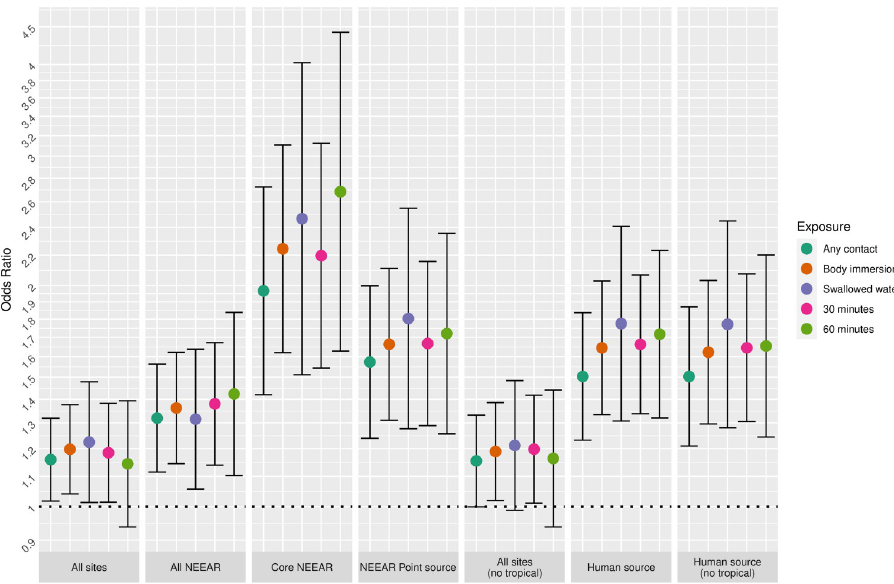
Site. Fig 10 highlights the impact of the type of site on the association between Enterococ- cus qPCR CE and diarrhea for several different age categories. Sites impacted by human sources and the core NEEAR sites tended to have higher risks than sites that were not impacted